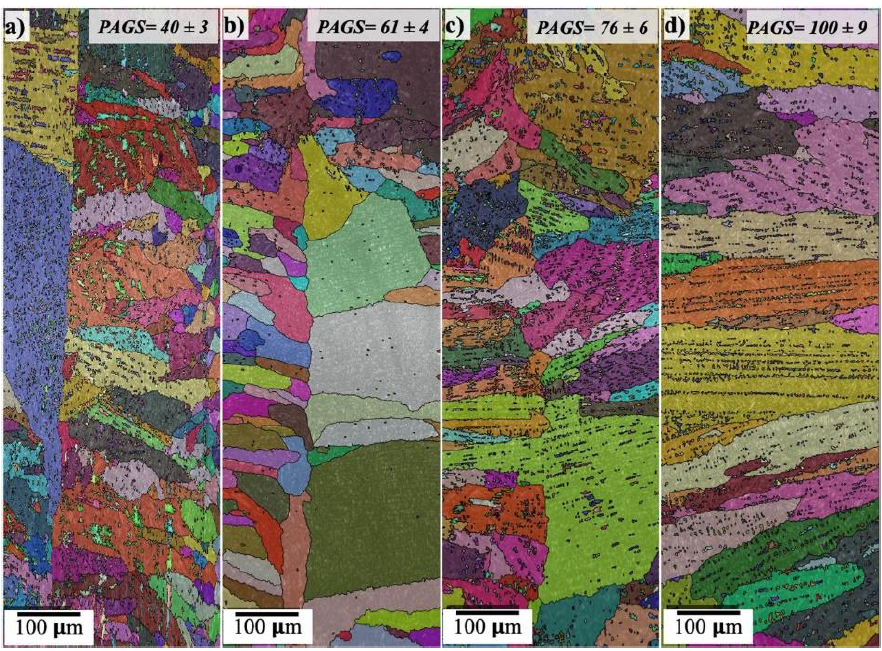
Figure 10. EBSD orientation maps superimposed with IQ maps for the prior austenite grains of the weld metal in the fusion zone at different laser EIs: ( a ) 50 J/mm; ( b ) 100 J/mm; ( c ) 160 J/mm; ( d ) 320 J/mm. The reconstructed PAG maps were created using MTEX and MATLAB software.